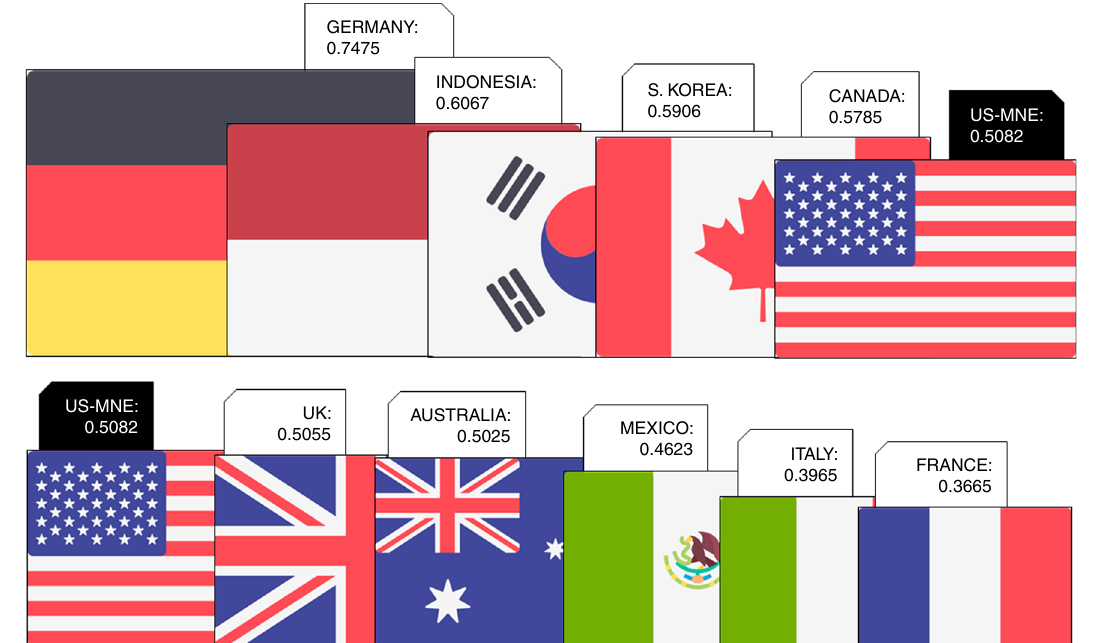
Fig. 1 2009 U.S. Multinationals carbon footprint among the world ranking of emitters (GtCO 2 ). See Supplementary Data 1. The fl ags icons in Fig. 1 are made by Freepik from www. fl